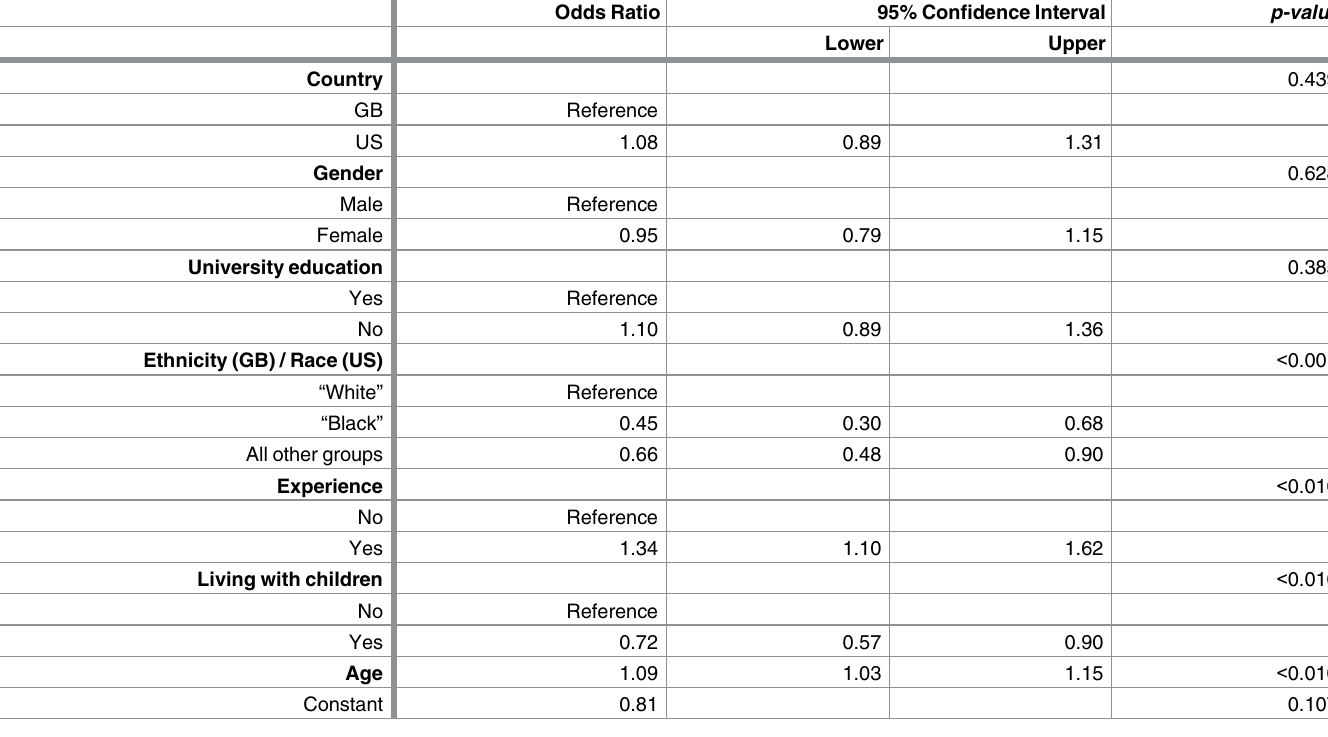
Table 3. Logistic regression for “measures to help me die peacefully” chosen at least once (n =